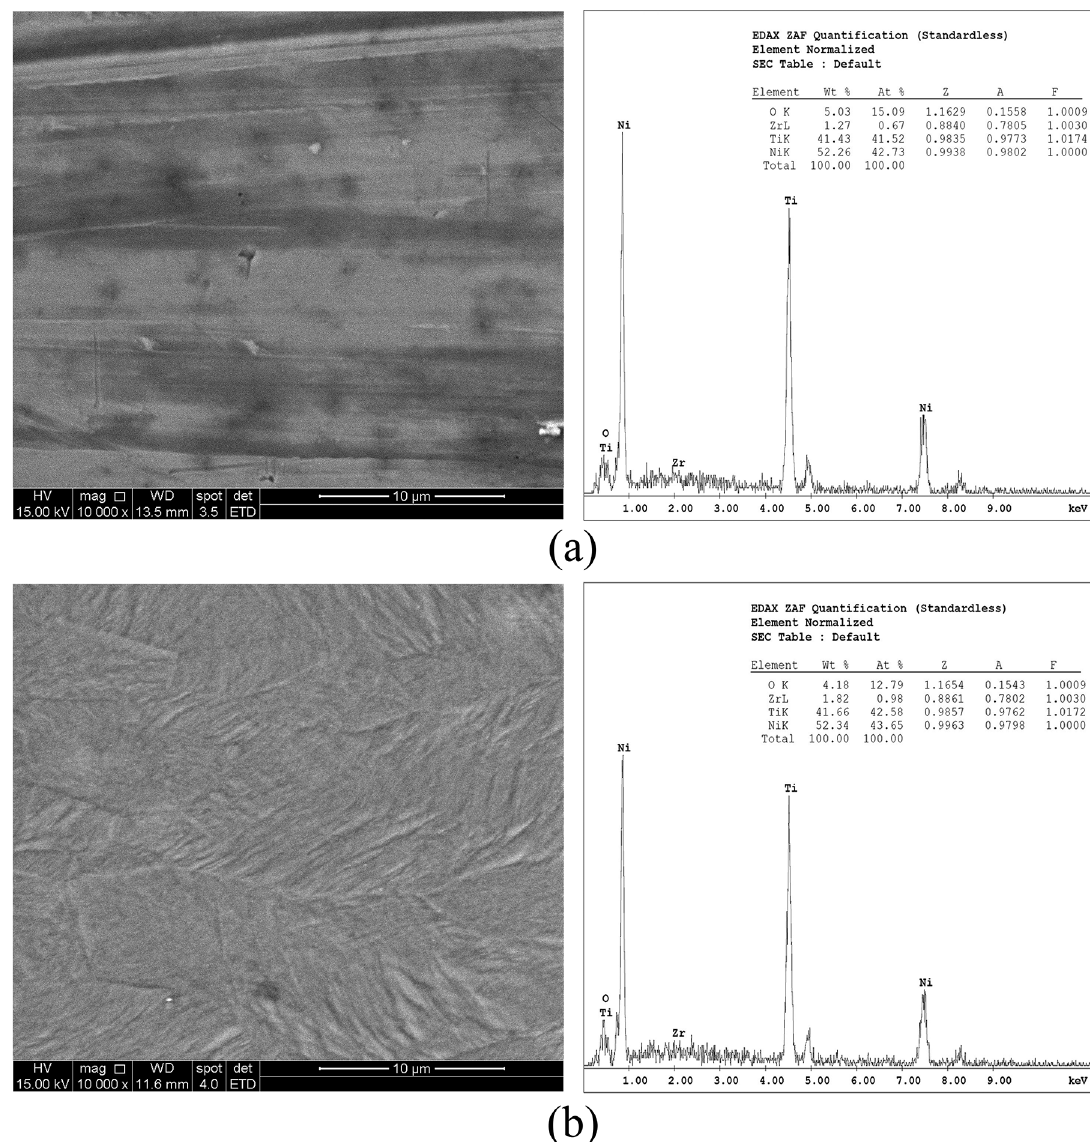
: (a) without prior electropolishing; and (b) with prior 2